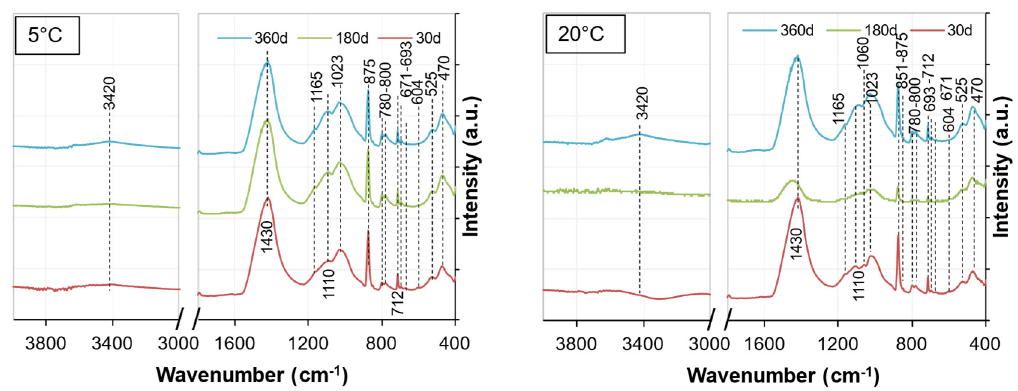
Figure A12. FTIR results of S + C + W3.